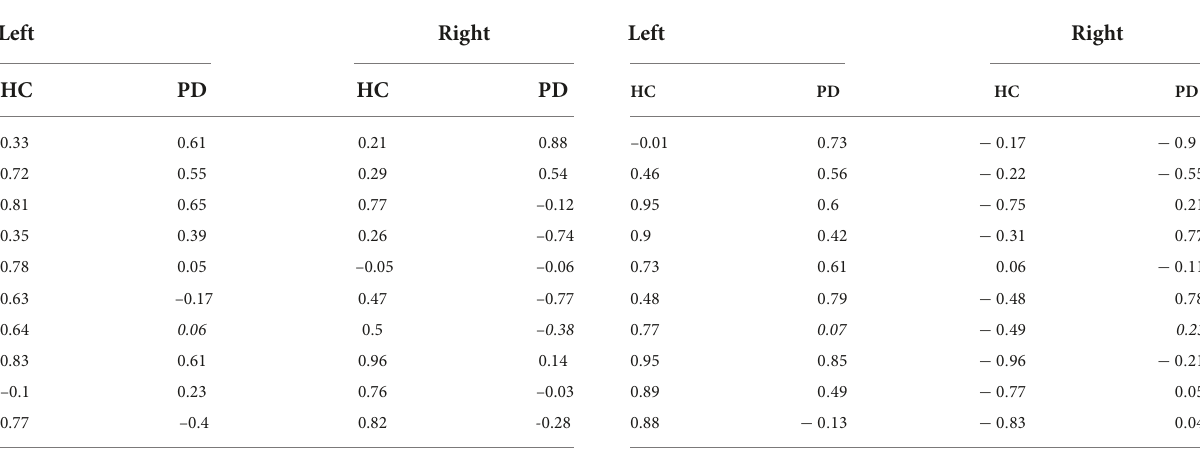
TABLE 4 Correlation between predicted minimum sensory-motor uncertainty and switching time variability, for healthy controls (HC) and PD patients, separated for the two starting locations of the ball.